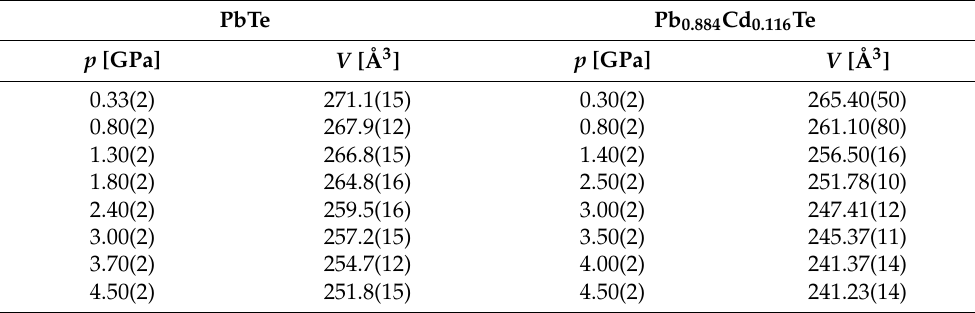
Table A3. Present high-pressure V ( p ) data from single-crystal structure refinement for PbTe